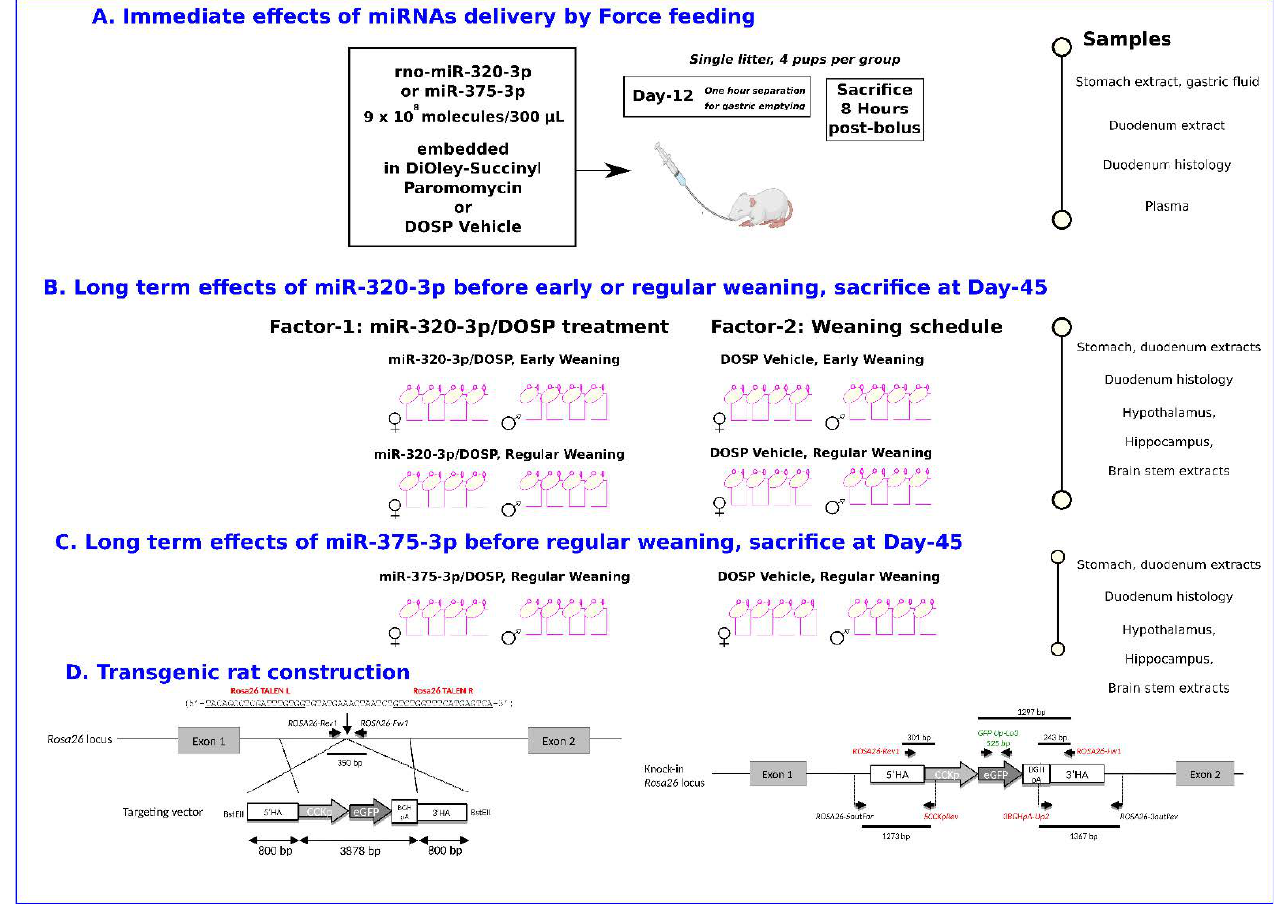
Figure 1. Study design. ( A ). Immediate effects of miRNA delivery. The rat pups at Day-12 (from one mother; n = 4 per group) were euthanized in the dark phase, 8 h after being fed with miR-320- 3p/DOSP, miR-375-3p/DOSP, or the vehicle solution of DOSP. Samples were collected from the stomach and duodenum. ( B ). Long-term effects of miR-320-3p/DOSP given before early or regular weaning. Four litters were used, two for the early weaning schedule (at Day-15, miR-320-3p/DOSP or control), and two for the regular-weaning schedule (at Day-30, miR-320-3p/DOSP or control). Each litter has eight pups (four males, four females), treated with miR-320-3p/DOSP or the vehicle solution of DOSP at Day-12. All animals were euthanized at Day-45. The experiment allowed us to evaluate the miR-320/DOSP treatment (Factor-1), the weaning schedule (Factor-2), and the interac- tion between factors. Samples were collected from the stomach, duodenum, hypothalamus, hippo- campus, and brain stem. ( C ). Long-term effects of miR-375-3p/DOSP given before regular weaning. Samples were collected from the stomach, duodenum, hypothalamus, hippocampus, and brain stem of eight rats from the same litter, treated with miR-375-3p/DOSP or the vehicle solution of DOSP at Day-12 and euthanized at Day-45. The second litter with eight rats receiving vehicle solution of DOSP and regular weaning was also done to check for differences with the first litter of rats treated with vehicle solution of DOSP at Day-12. In the gut, we have sampled the stomach as the inoculation site and the duodenum as relevant for our transgene expression. The rationale for choosing each brain area was for the hypothalamus as the main center of energy homeostasis , the hippocampus as involved in the memory of food reward and choice, and the brain stem as the outcome of the vague nerve linking the intestine to the brain. We have screened the effects according to gene sets related to the inflammatory and enteroendocrine status of the stomach or duodenum and on the seroto- ninergic/dopaminergic balance of brain areas. To illustrate the up- and downregulation of genes, our results were also presented as networks of miRNA and mRNA significantly deregulated in our dataset. Our transgenic GFP-CCK-p rat derived from the Sprague – Dawley strain allows us to follow an enteroendocrine cell lineage labeled with Green Fluorescent Protein in duodenum crypts. ( D ). Transgenic rat generation. Targeted integration of a CCK promoter-GFP cassette into the rat Rosa26 locus ( left panel ). Schematic representation of the rat Rosa26 locus. TALEN cleavage (vertical ar- row) in the first intron, as well as the sequences recognized by both TALENs, the targeting vector